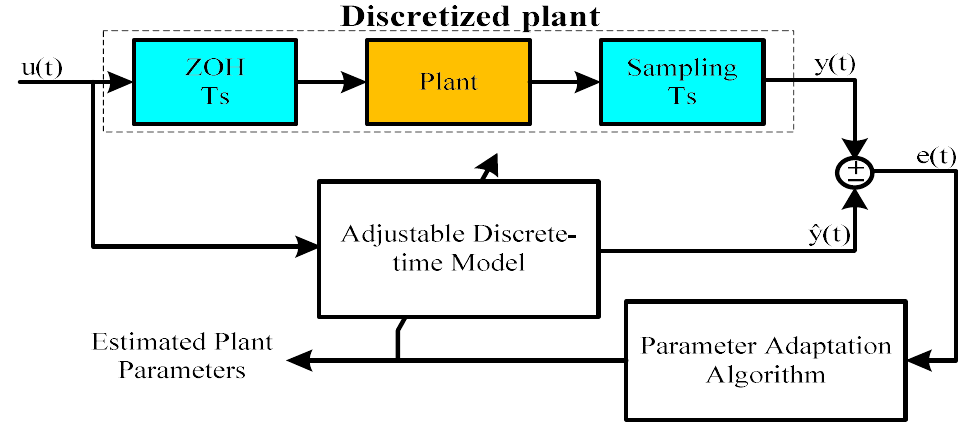
Figure 3. Parameter estimation of discrete-time models.